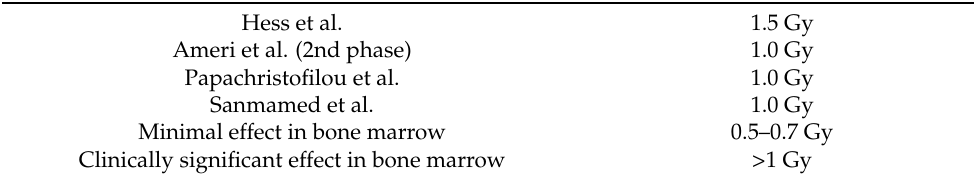
Figure 4. Some of the most important immune- and inflammation-related processes that develop after low-, intermediate-, and high-dose irradiation. (Reproduced from [42]). Table 2. The radiation doses required for minimal and clinically significant effects in bone marrow compared to doses used in some clinical